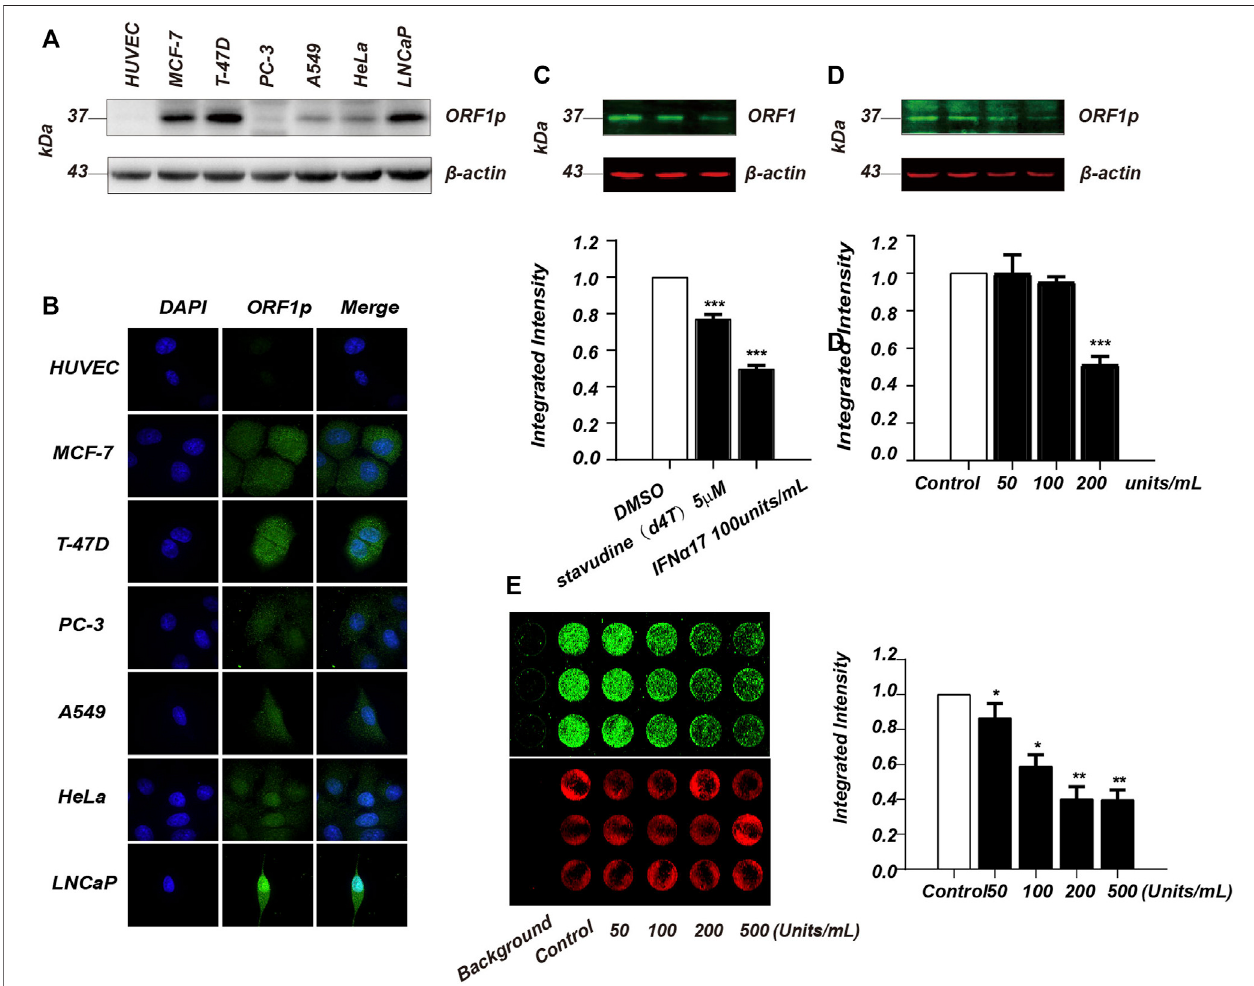
FIGURE 1 | Establishment of ICW-based screening assay for LINE-1 ORF1p inhibitor screen. (A) , Immunoblotting analysis of LINE-1 ORF1p expression in six cancer cell lines including MCF7, T-47D, PC-3, A549, HeLa and LNCaP. (B) , Immuno fl uorescence assay of LINE-1 ORF1p expression in the cancer cell lines indicated. (C) , Immunoblotting analysisevaluationof theinhibitoryactivity ofIFN α 17and d4T upon LINE-1ORF1p in T-47D cells. (D) , TheT-47D cells were treated withincreasing doses of IFN α 17 (50, 100, 200, and 500U) and LINE-1 ORF1p expression level was detected 48 h later by immunoblotting analysis. (E) , ICW assay analysis of LINE-1 ORF1p expression level in T-47D cells after being treated by increasing doses of IFN α 17. All experiments were performed three times and statistical signi fi cance was determined using Students two-tailed t -test. * p < 0.05, ** p < 0.01.